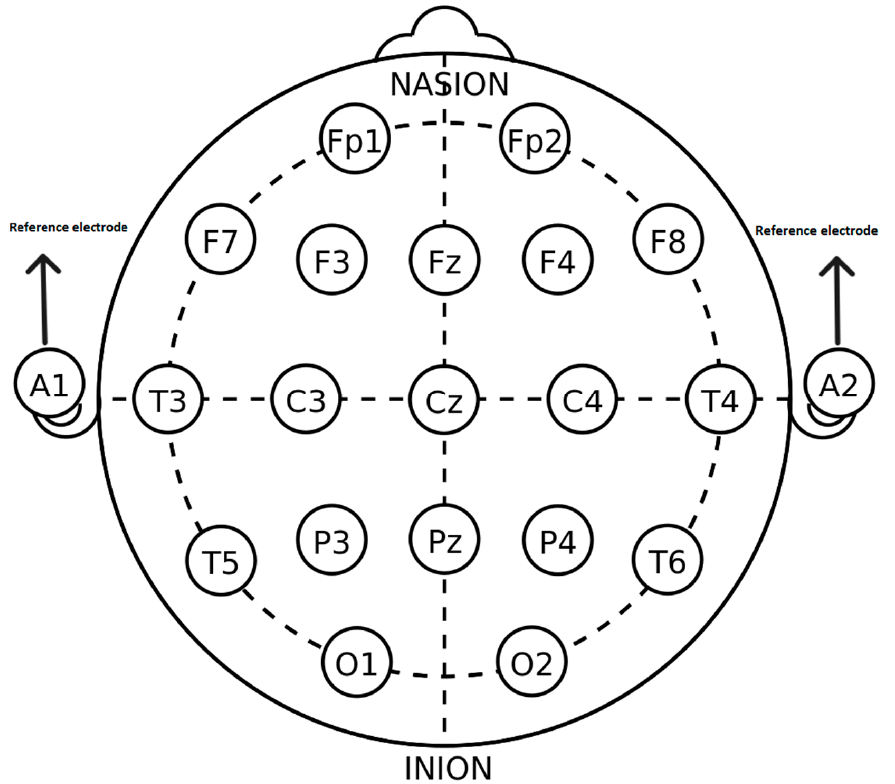
Figure 1. The 10–20 system for electrode position with A1 and A2 reference electrodes [29]. The recording protocol was designed based on a visual attention task. In the task, the children were shown 20 images with several age-suitable characters, such as images of different animals, and they were asked to enumerate them. The number of characters in each image was chosen between 5 and 16 randomly. To have a continuous stimulus during the EEG recording, each image was displayed immediately after the child’s response. Thus, the child’s performance defines the duration of the EEG recording. The correctness of the answers was not considered